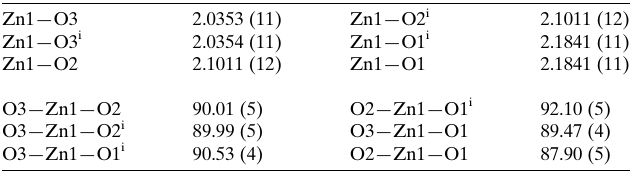
Table 2 Hydrogen-bond geometry (A˚ , (cid:4) ).